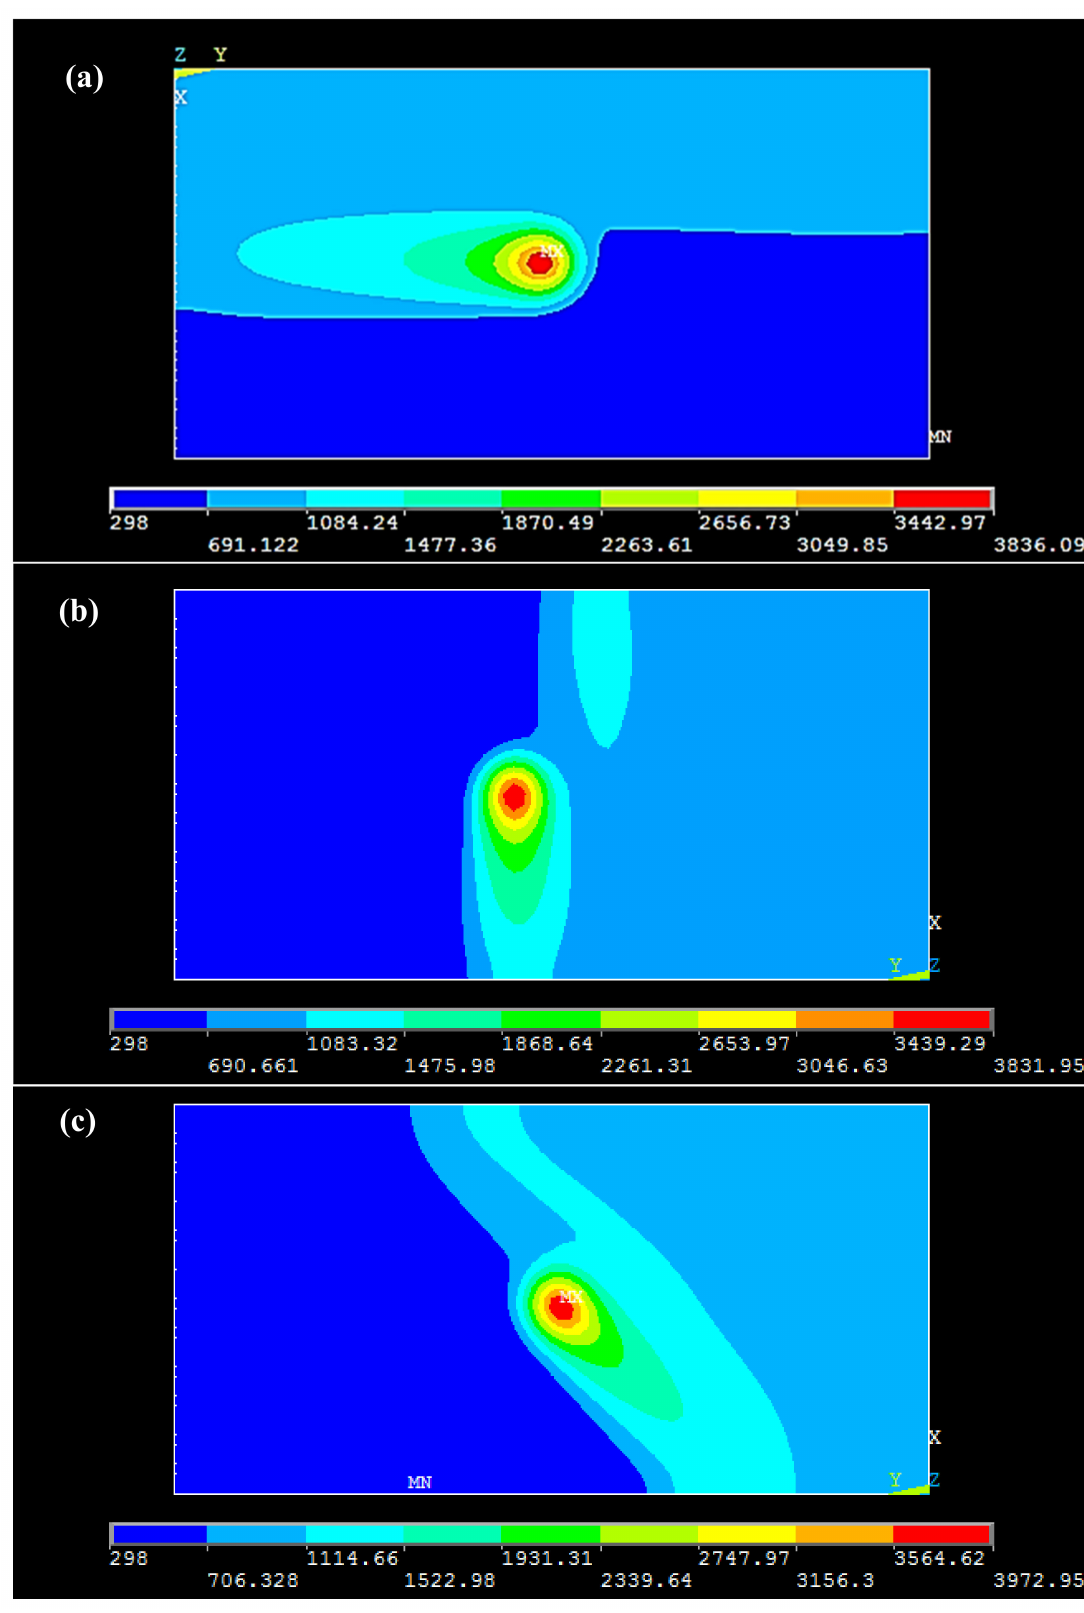
Figure 8. Temperature distribution at the top powder top surface for laser movement along ( a ) Y-scan, ( b ) X-scan, ( c ) XY-scan path. For P = 80 W, v = 1